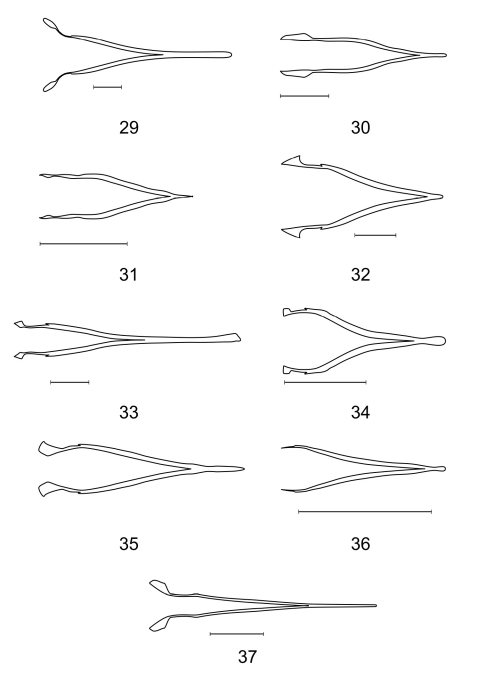
Spicular forks of 29
Aphelochroa sp. 30
Caridopus monstruosus
31
Dozocolletus discophorus
32
Gyponyx sp. 33
Neorthrius sp. 34 Nonalatus brevis 35
Orthrius sepulcralis
36
Pseudoastigmus pygidialis
37
Xenorthrius simplex. Scale bars 0.5mm.